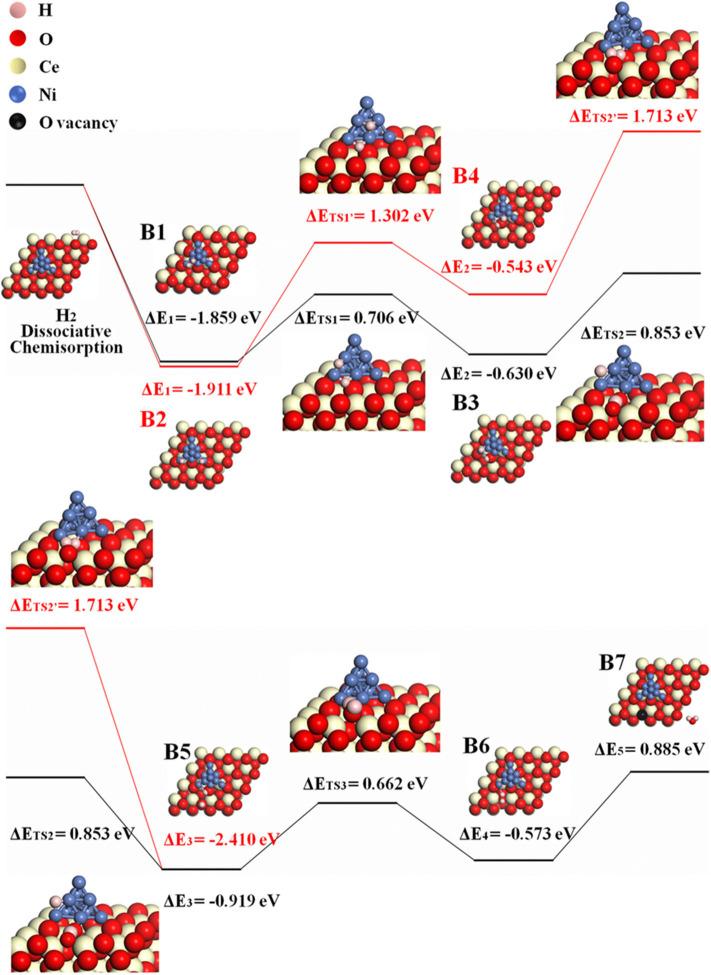
The H-spillover pathways of H2 oxidation in the Ni10-CeO2(111) system with hydrogen adsorption on Ni10 and oxidation reaction at 3PB (pathway III in black lines and pathway IV in red lines).